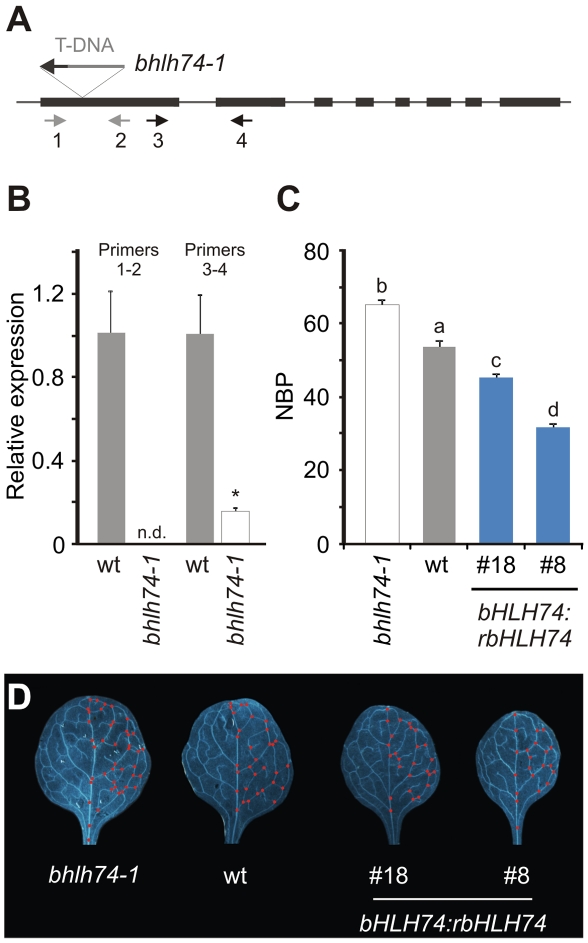
Analysis of bhlh74 mutants.(A) Scheme of the bHLH74 locus showing the T-DNA insertion corresponding to the GABI-Kat 720G11 line. Arrows indicate the pairs of primers (1–2 or 3–4, see also Table S7) used to quantify bHLH74 transcript levels by RT-qPCR. (B) bHLH74 transcript levels in wt and bhlh74-1 (GABI-Kat 720G11) seedlings (12–day old), using pairs of primers shown in (A). Data shown are mean ± SEM of 3 biological replicates; n.d.: not detected. Asterisks indicate significant differences between mutant and wild-type plants, as determined by ANOVA (P<0.05). (C) Number of branching points (NBP) in fully-expanded first leaves of wt, bhlh74-1 and bHLH74:rbHLH74 (lines #18 and #8) plants. Bars marked with different letters are significantly different as determined by ANOVA and Duncan's multiple range test (P<0.05). (D) Fully-expanded leaves (#1) from wt, bhlh74-1 and bHLH74:rbHLH74 (lines #18 and #8) plants. Red dots highlight branching points.